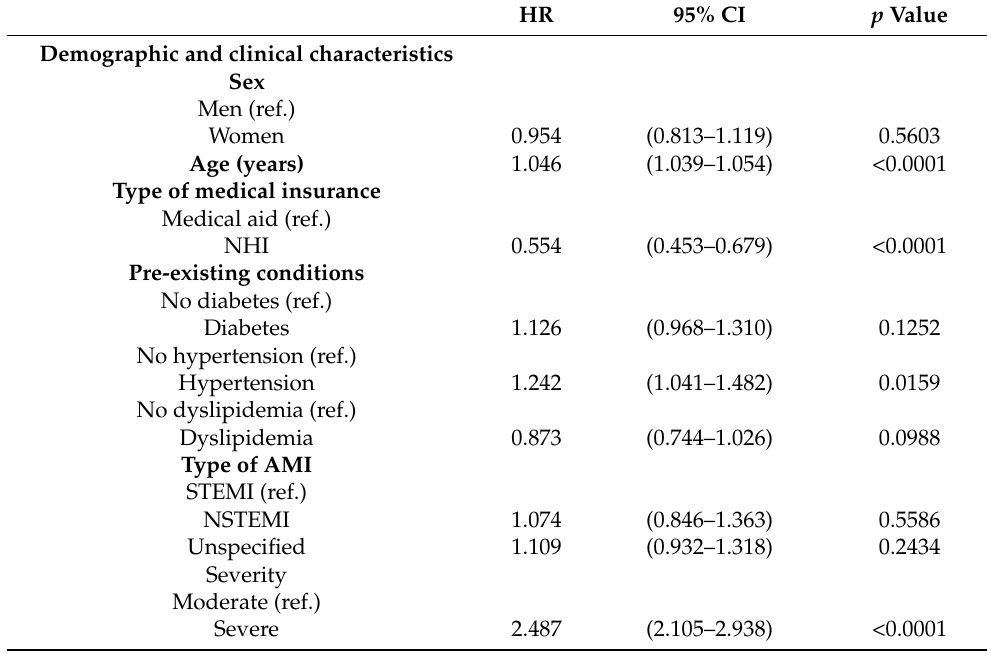
Table 4. The impacts of covariates on late onset HF with Cox-proportional hazard models. HR 95% CI p Value Demographic and clinical